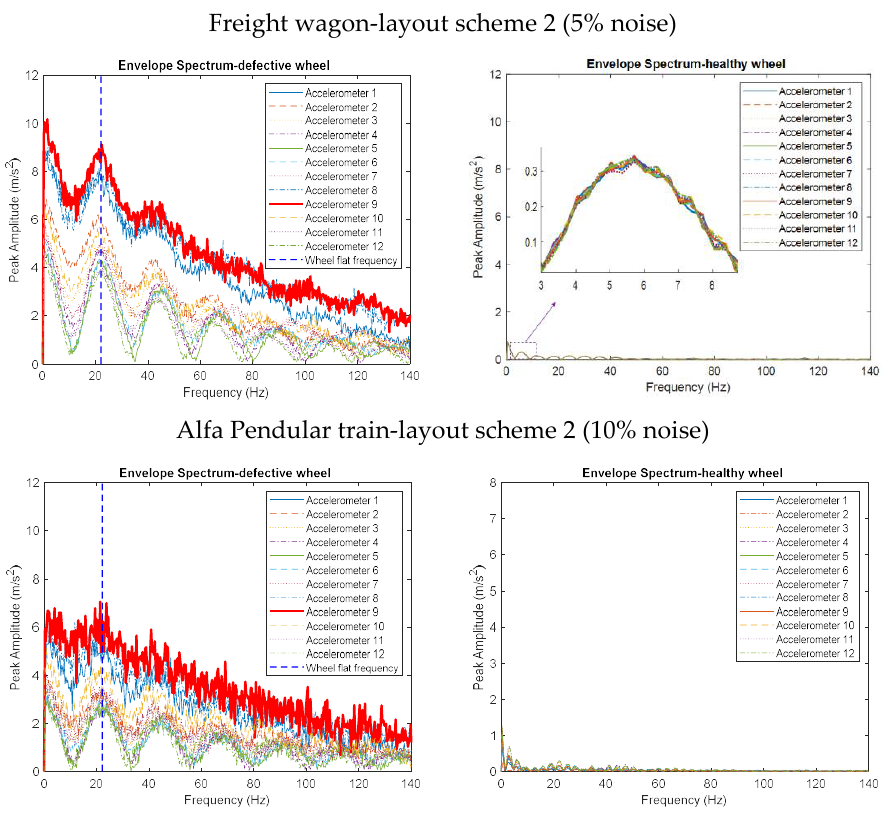
Figure 13. Envelope spectrum analysis for the 12 accelerometers (layout scheme 2) with different noise intensities and considering a defective and healthy wheel of the Alfa Pendular train and the freight wagon.